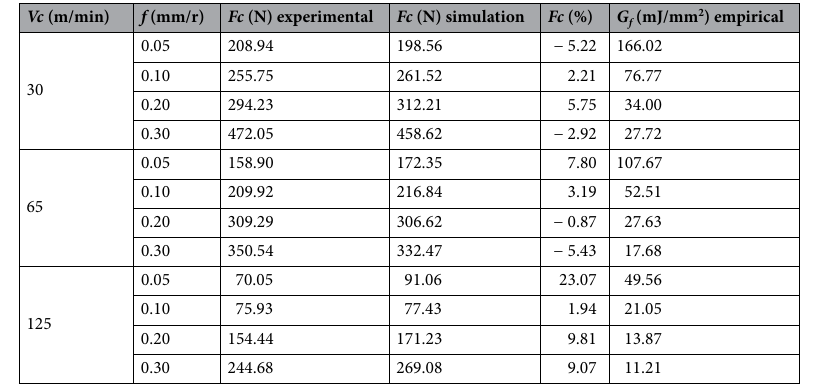
Table 9. Cutting forces evaluation for each G f calculated.